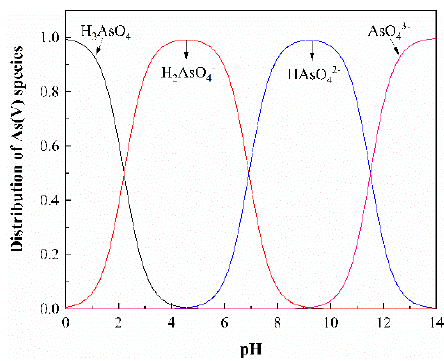
Figure 10. Distribution of As(V) species as a function of pH based on the equilibrium constants. Figure 10. Distribution of As( Ⅴ ) species as a function of pH based on the equilibrium constants. Figure 10. Distribution of As( Ⅴ ) species as a function of pH based on the equilibrium constants. Figure 10. Distribution of As( Ⅴ ) species as a function of pH based on the equilibrium constants.